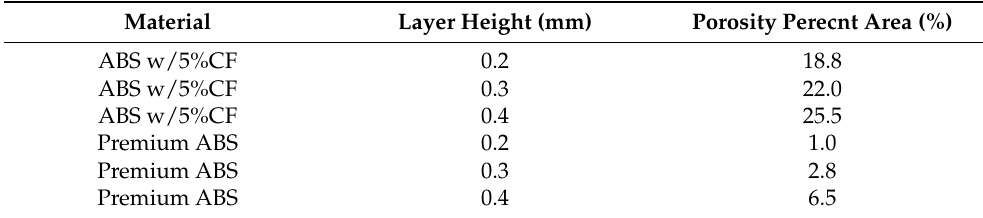
Table 2. Porosity percent area determinations of optical images in Figures 9 and 10.